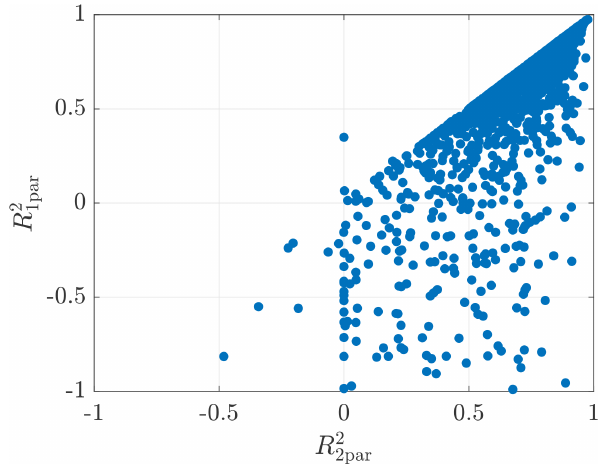
Figure A4. Comparison of the fitting quality ( R 2 ) of the two- parameter wind evolution model (Eq. 8) and that of the one- parameter wind evolution model (Eq. 5). The subscripts “1par” and “2par” indicate one-parameter and two-parameter, respectively.